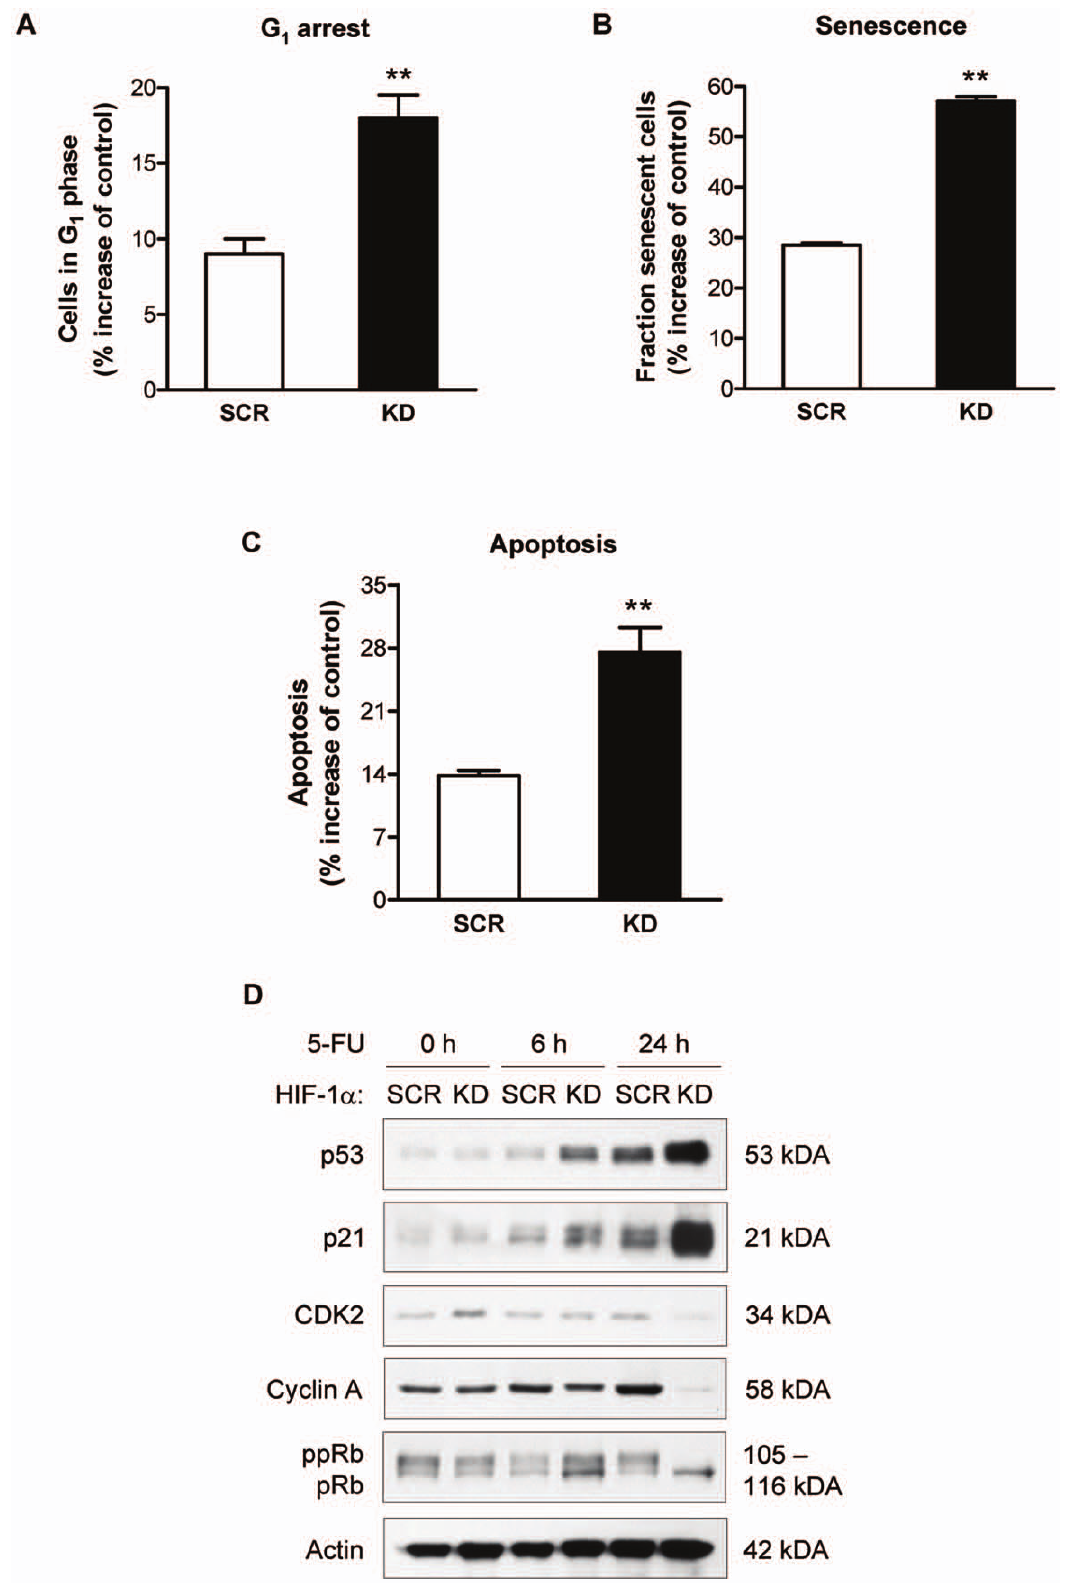
Figure 2. HIF-1 a mediates resistance towards 5-FU by blocking p53-dependent G 1 arrest and apoptosis. (A) AGS KD and SCR cells were treated for 24 h with 10 m g/ml 5-FU, and cell cycle distribution was determined by FACS analysis (**, P , 0.01). (B) Chemotherapy-induced senescence was quantified in AGS KD and SCR cells 4 days after treatment with 5-FU by measurement of SA- b -Gal activity (**, P , 0.01). (C) AGS KD and SCR cells